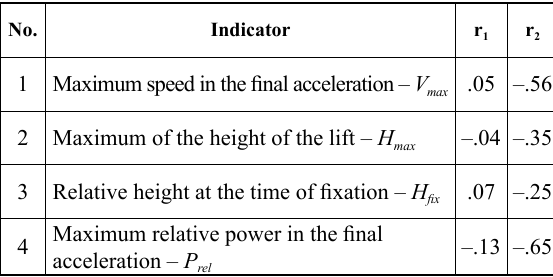
Figure 3. The cor- relation field ( r = – .56) and the re - gression equa - tion between the maximum of the speed in the final acceleration and the coefficient of the efficiency of the techniques in the snatch in men ( n = 184)